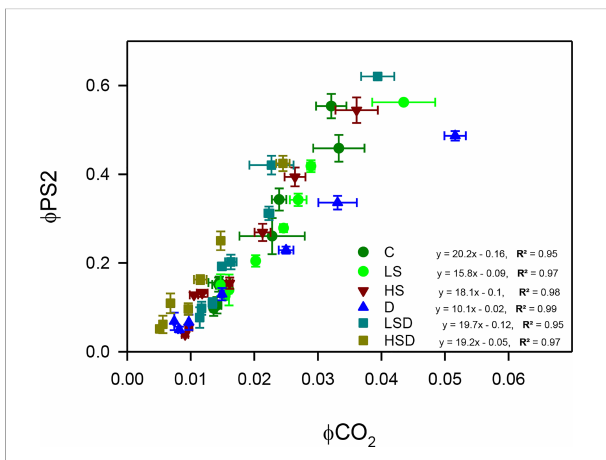
FIGURE 5 The ratio between quantum ef fi ciencies of linear electron transport through PSII and of CO 2 assimilation ( F PSII/ F CO 2 ) of Panicum antidotale under salt (0, 100, 300 mM NaCl; abbreviated as C, LS, and HS respectively), drought (D) and combination of both (abbreviated as LSD and HSD). The values represent the means and ± S.E. (n = 3) where n is number of plants sampled from different